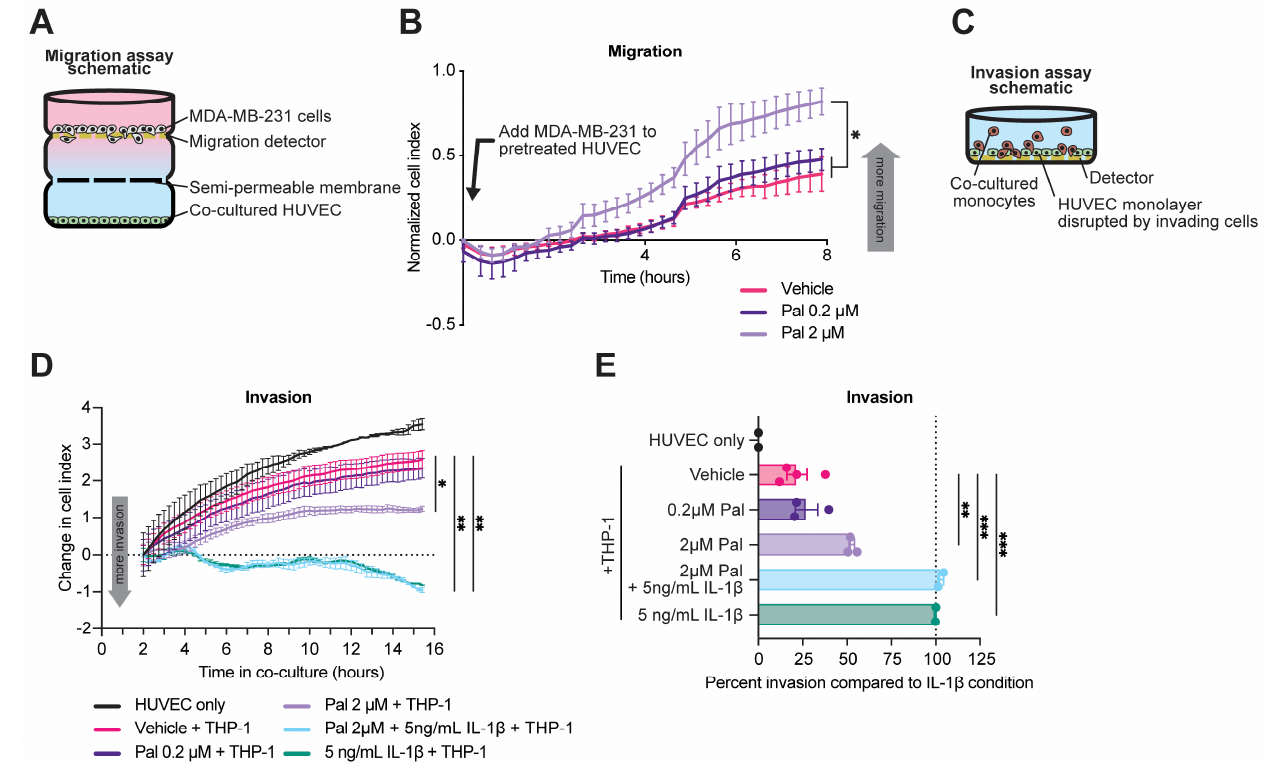
Figure 5. Palbociclib treatment of HUVEC modulates tumor cell migration and monocyte invasion in vitro. ( A ) Schematic of three-chamber co-culture system. ( B ) MDA-MB-231 migration after initiation of co-culture. HUVEC treated with vehicle or palbociclib (Pal) at indicated doses. Increasing cell index indicates more migration. ( C ) Schematic of trans-endothelial invasion co-culture assay. ( D ) Trans-endothelial invasion of THP-1 monocytes exposed to pretreated endothelial cell monolayer with indicated treatments of vehicle, palbociclib, or recombinant interleukin-1 β (IL-1 β ) at indicated doses. Change in cell index is reported beginning two hours after initiation of co-culture. ( B , D ) compared by two-way repeated measures ANOVA with Dunnett’s multiple comparisons test, * p < 0.05, ** p < 0.01. ( E ) Measurements of THP-1 invasion relative to IL-1 β positive control and non-THP-1-containing condition as negative control compared by one-way ANOVA with Tukey’s multiple comparisons test. ** p < 0.01, *** p < 0.001.